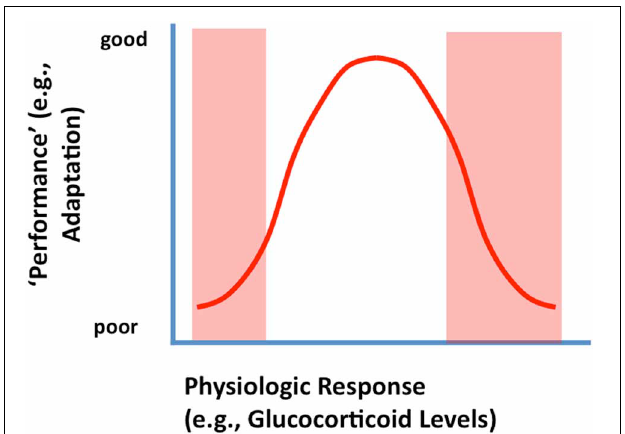
FIGURE 1 | Inverted U-shaped relationship between physiologic or behavioral “performance’ and HPA axis output (corticosterone secretion). Secretion of glucocorticoids following stress is likely an adaptive function, supplying needed energy to meet real or potential threats. Underactive stress axis activation does not mobilize the resources needed to meet a challenge, resulting in suboptimal performance (left arm of the U-shaped curve). Excessive glucocorticoid secretion (right arm of the U-shaped curve) can cause excessive or prolonged catabolic responses, which can result in turn-off of vital stress counter-regulatory systems or energetic challenge in the CNS (see